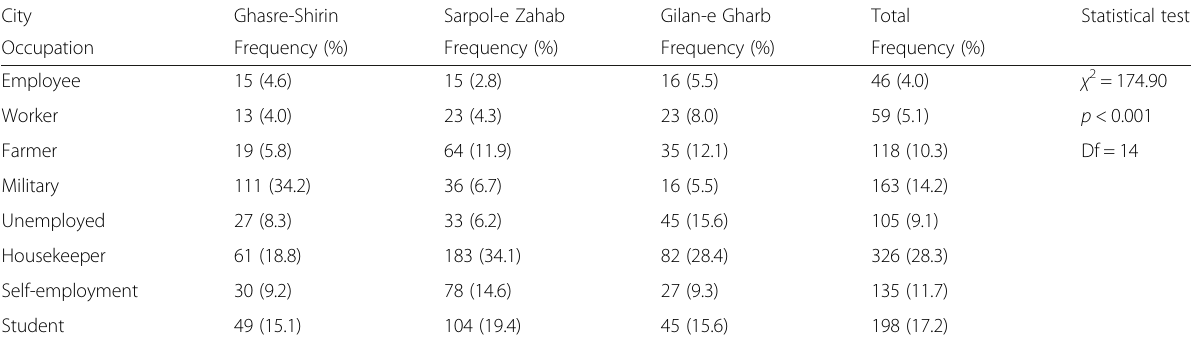
Table 4 Frequency distribution of scorpion stings according to occupation in tropical areas of Kermanshah City